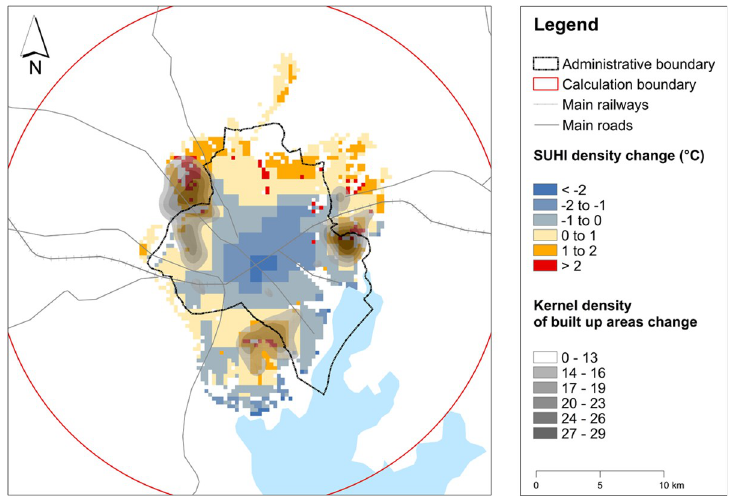
Fig 4. Daytime SUHI value distributions for Kampala urban cluster in 2003 and 2017. The width of each curve corresponds with the approximate frequency of data points. There is a small box plot in the middle of each density curve, with the rectangle showing the ends of the first and the third quartiles and central line the median. The n value under the x-axis is the number of SUHI pixels.